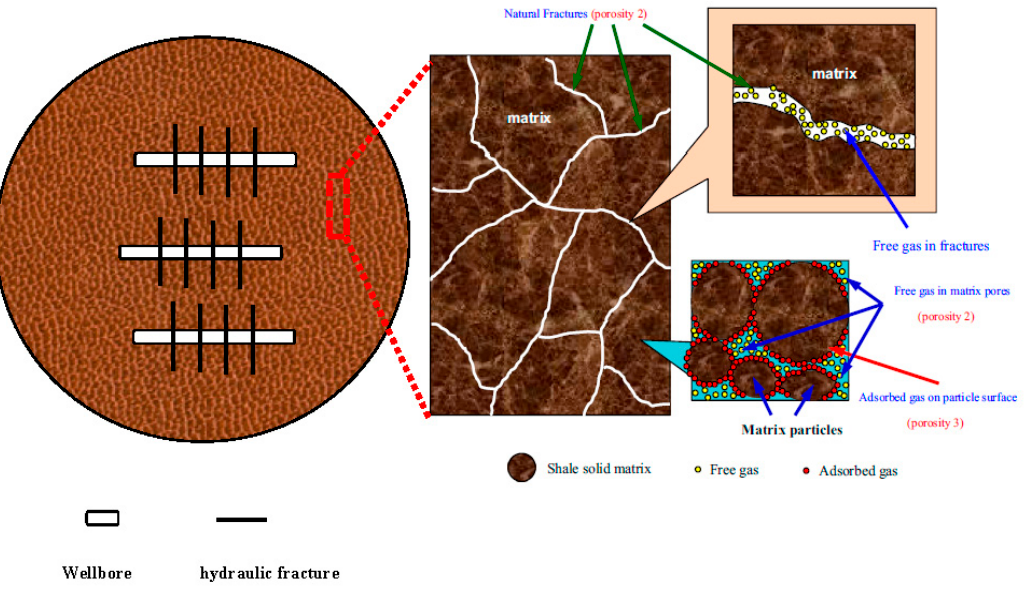
Figure 3. Conceptual model for a typical shale gas reservoir.